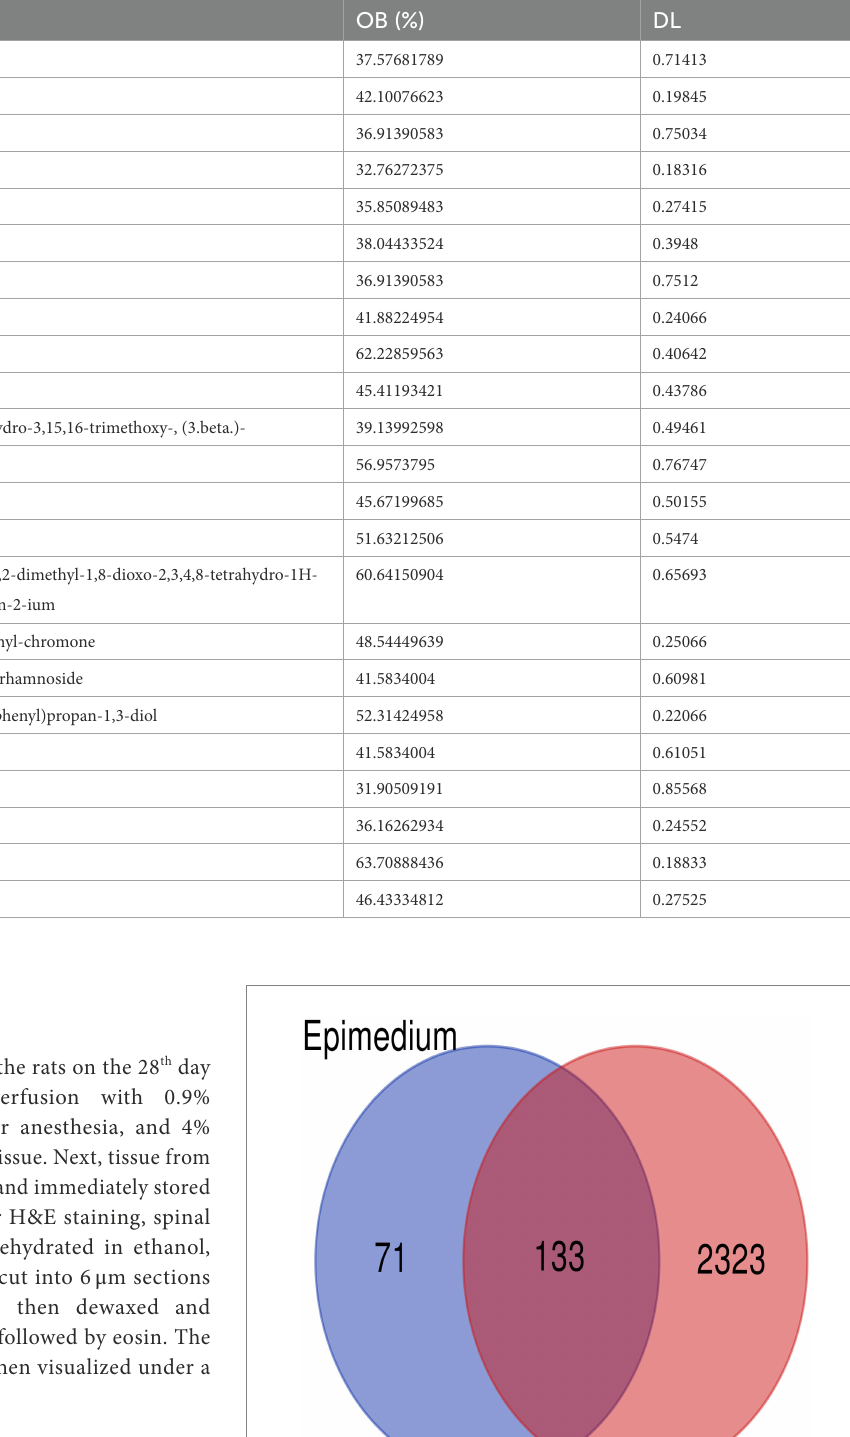
TABLE 1 OB and DL values of the 24 active compounds of EPI Molecule ID. Mol